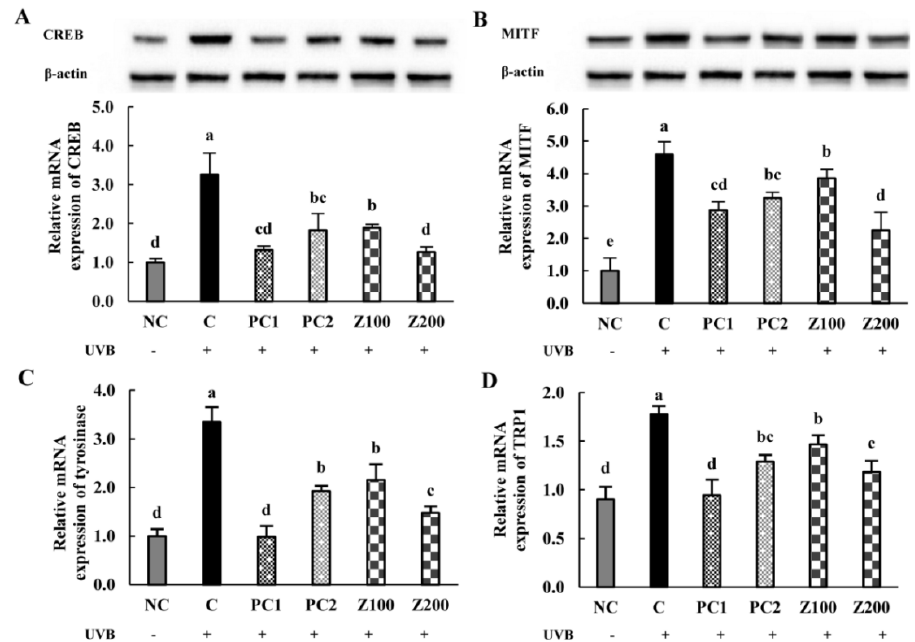
Figure 6. Inhibitory effects of FSH-ZM on the expressions of mRNA and proteins related to melanogenesis in skin from the back of UVB-irradiated HRM-2 hairless mice. ( A ) The expression of CREB at mRNA and protein level. ( B ) The expression of MITF at mRNA and protein level. ( C ) The expression of tyrosinase mRNA. ( D ) The expression of TRP1 mRNA. NC, normal control; C, UVB-irradiated control; PC1, positive control 1, L-ascorbic acid 200 mg/kg b.w.; PC2, positive control 2, Arbutin 200 mg/kg b.w.; Z100, FSH-ZM 100 mg/kg b.w.; Z200, FSH-ZM 200 mg/kg b.w. Values are presented as mean ± standard deviation (n = 6), and different superscript letters indicate significance at p < 0.05.